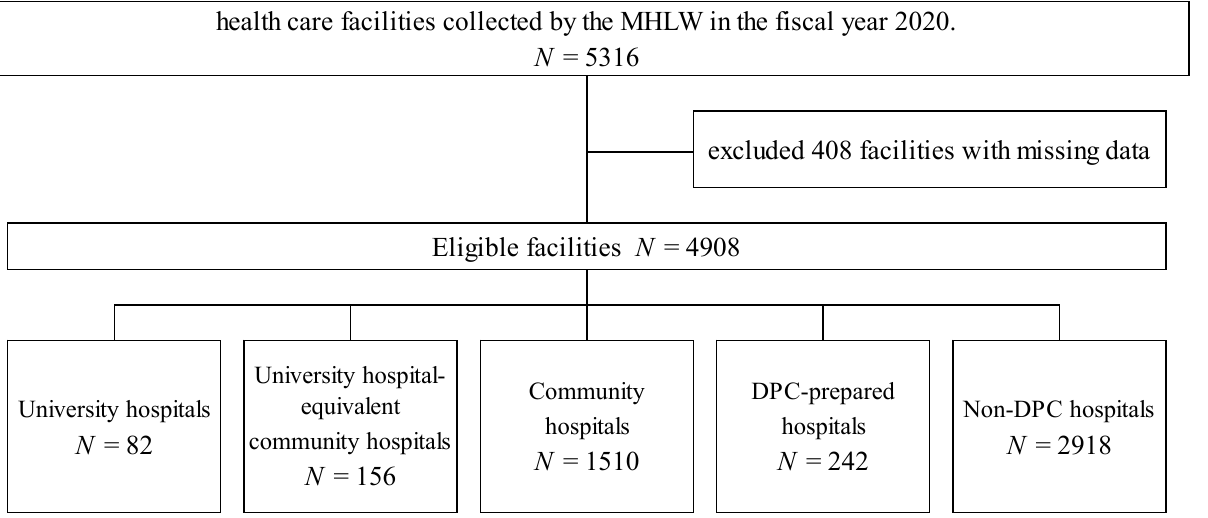
Figure 1. Study flow diagram showing the stratification and selection of patients in the Diagnosis Procedure Combination database by the Ministry of Health and Welfare in the fiscal year 2020. Table 1. Characteristics of hospitals stratified by facility type.